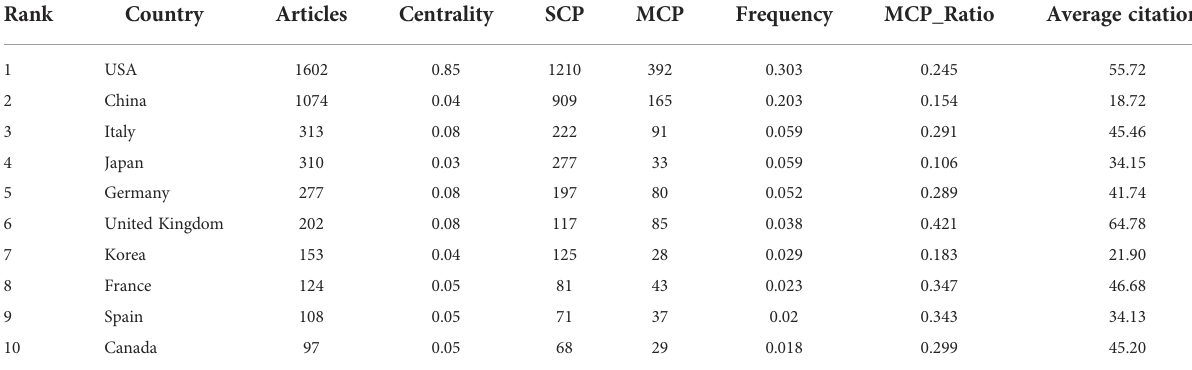
TABLE 1 Global Publications in the 10 most productive countries/regions.